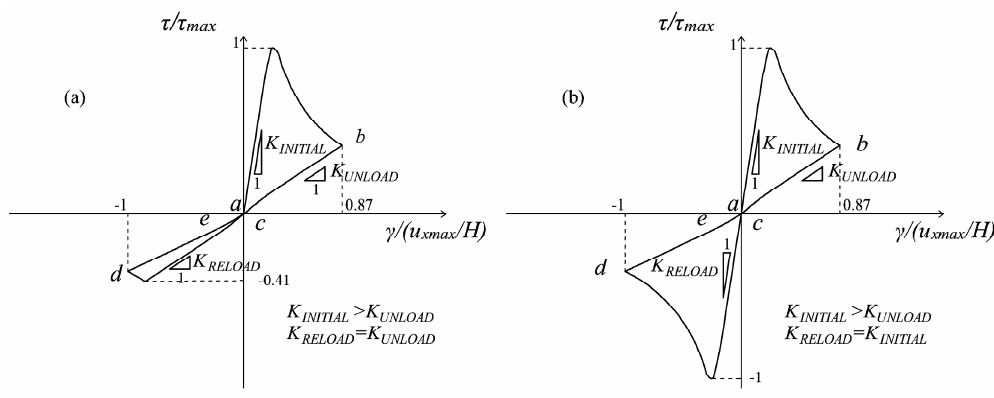
Figure 11. Structural response for the problem represented in Figure 5a, ratio m = 8: ( a ) damage formulation presented in Section 2 and ( b ) multidirectional damage model.